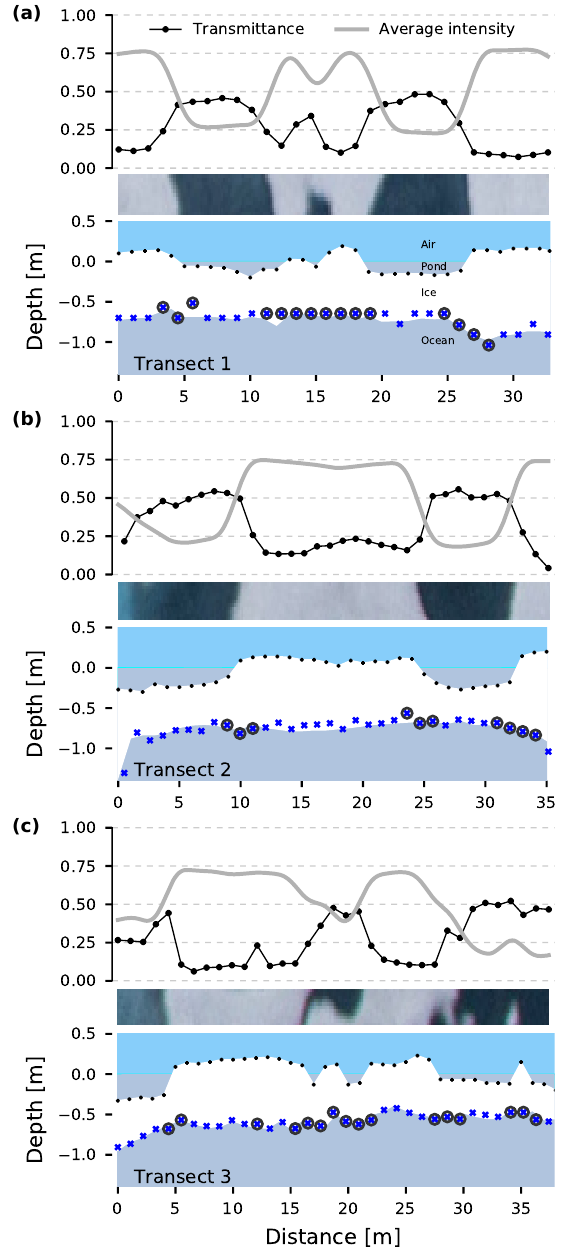
Figure 4. Bulk transmittance and average intensity of ice (upper subpanels), aerial photo (middle subpanels), and pond depth and ice thickness (lower subpanels), for (a) transect 1, (b) transect 2, and (c) transect 3. The average intensity is calculated as described in Sect. 2.4.1. The profile of ice thickness and pond depth is based on measurements of ice thickness, pond depth, and freeboard per- formed along the three transects. Black dots along the ice surface in the lower panels indicate locations of thickness drillings; blue crosses near the ice bottom indicate the locations of under-ice irra- diance measurements, with the depth as given by the pressure sensor of the RAMSES instrument. Circled blue crosses indicate measure- ments that are identified as being close to pond edges.